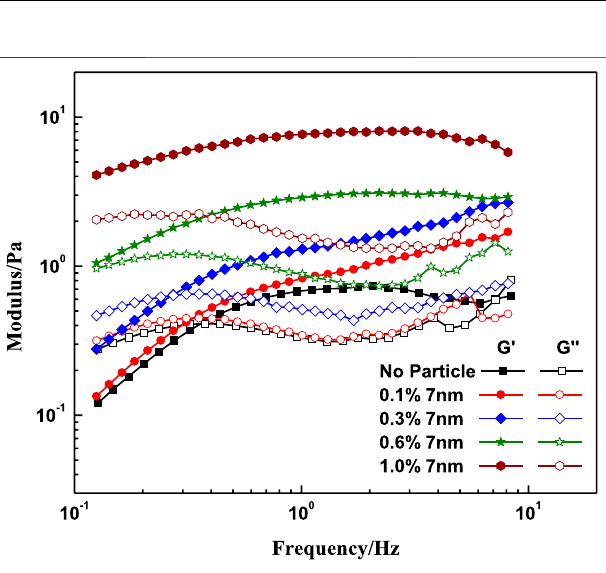
FIGURE 11 | Effect of SiO 2 concentration on the modulus with different shear stress. ( w (LBA + SDS) (cid:2) 0.8%, LBA:SDS (cid:2) 3:1, T (cid:2) 50 ° C, w (NaCl) (cid:2) 4%, frequency (cid:2) 1Hz).